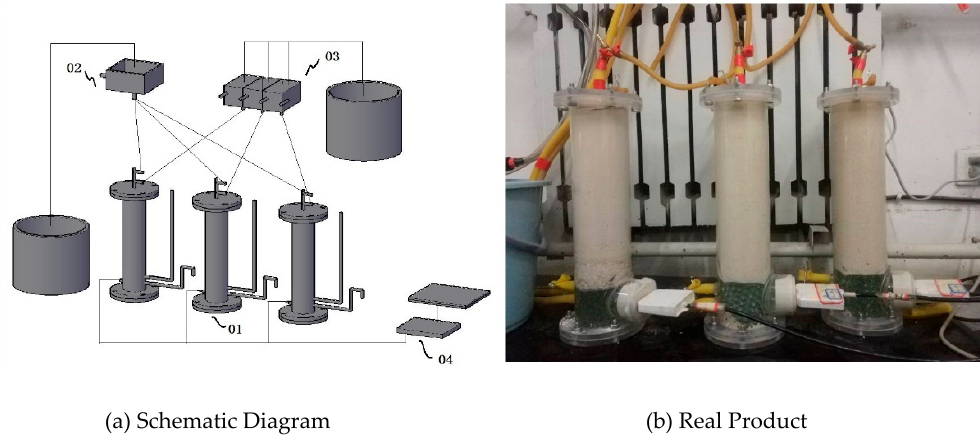
Figure 3. One-dimensional dispersion device (01: one-dimensional soil column, 02: freshwater supply tank, 03: tracer supply tank, 04: data acquisition system).